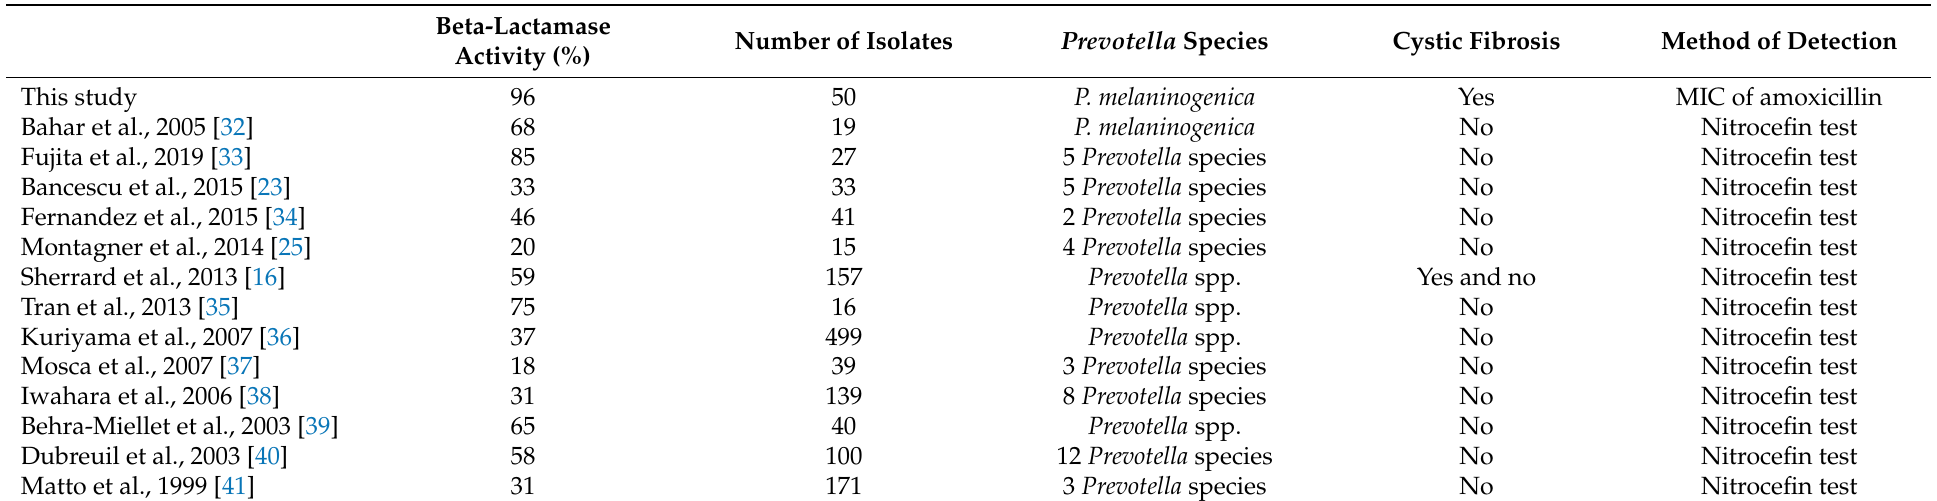
Table 3. Studies reporting the percentage of beta-lactamase activity in Prevotella